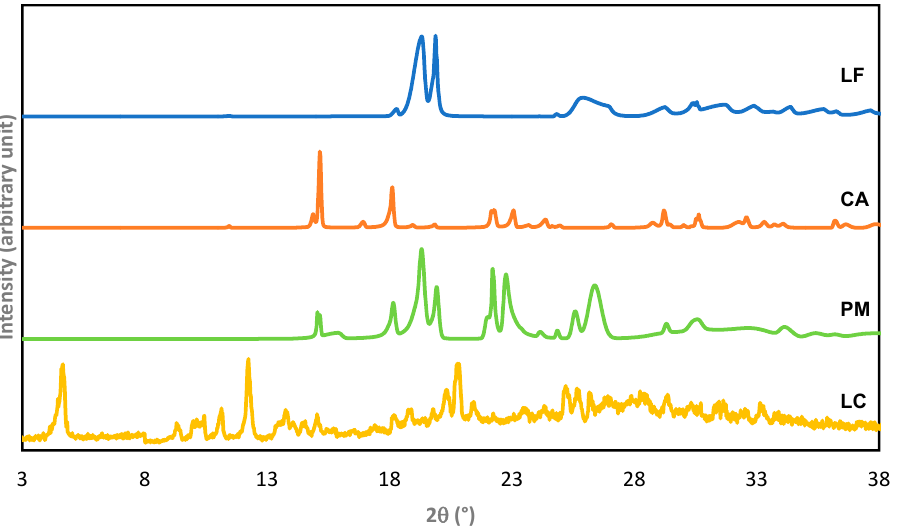
Figure 4. Powder X-ray diffractogram of levofloxacin citrate (LC) compared to the starting materials, levofloxacin (LF)—hemihydrate, and citric acid (CA)—dihydrate, and a physical mixture (PM) of LF and CA.